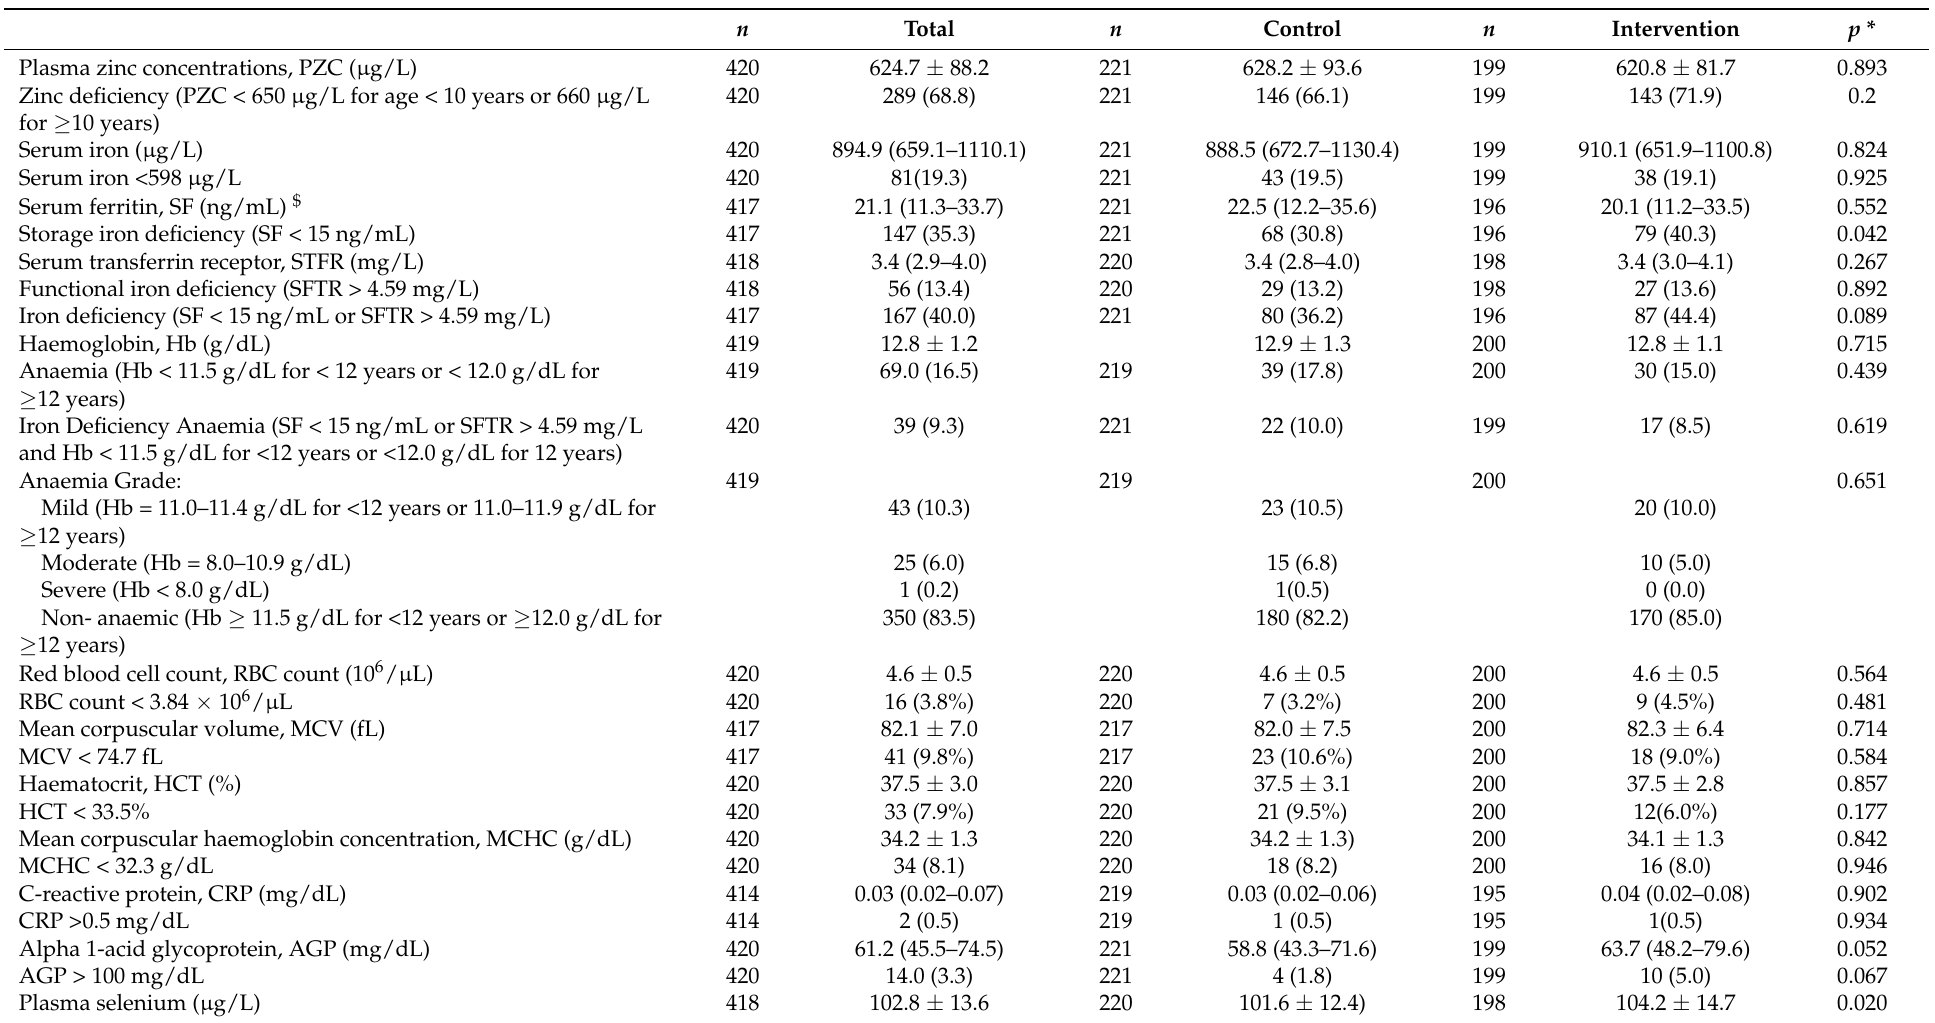
Table 2. Baseline values for haematological outcome measures of the enrolled adolescent girls. n Total n Control n Intervention p